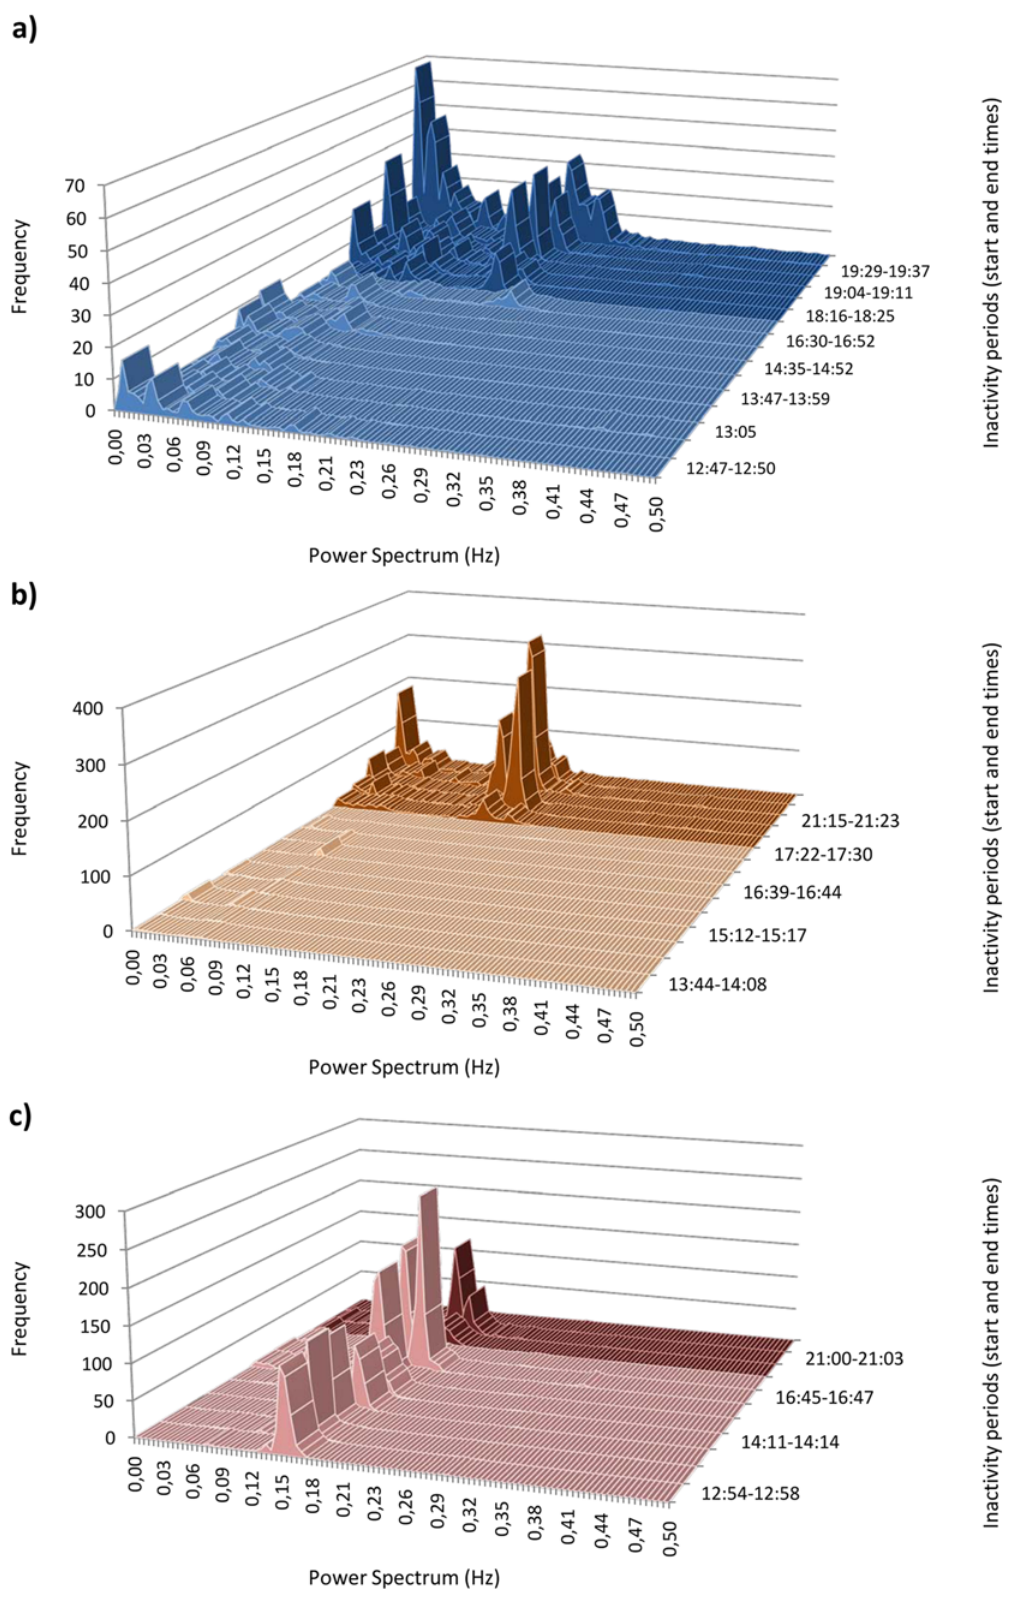
Figure 4. Spectral analysis of the heart rate variability during periods of inactivity throughout the recording periods for a) Nemo (no contact with human), b) Nugget and c) Crimson.